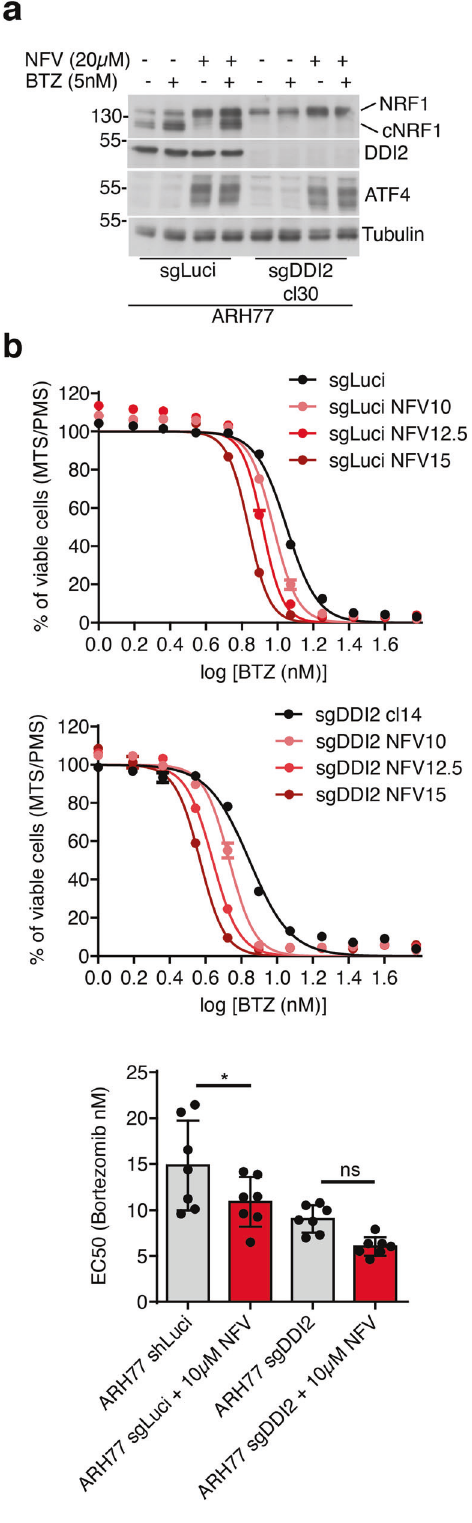
Fig. 5 Nel fi navir increased Bortezomib sensitivity. a, b ARH77 cells control population, or de fi cient for DDI2 were treated with BTZ in the presence or absence of Nel fi navir (NFV) as indicated. Protein expression of DDI2, NRF1, and ATF4 was assessed by immunoblot Blot. Tubulin is used as a loading control ( a ). BTZ sensitivity was analyzed by viability assay; curves are from one representative experiment performed in triplicate. Dots graph represents the EC50 (half-maximal effective concentration) of the dose responses; data are from independent experiments performed in triplicate. P -values were calculated using one-way ANOVA with Bonferroni multiple comparison